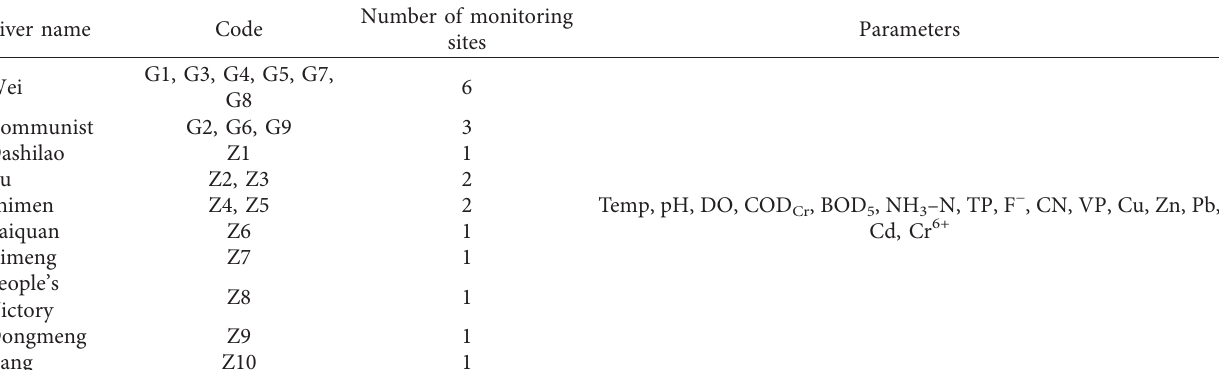
Figure 1: Map of the study area and surface water monitoring sites in the Xinxiang Section of the Wei River (XSWR). Table 1: River water monitoring